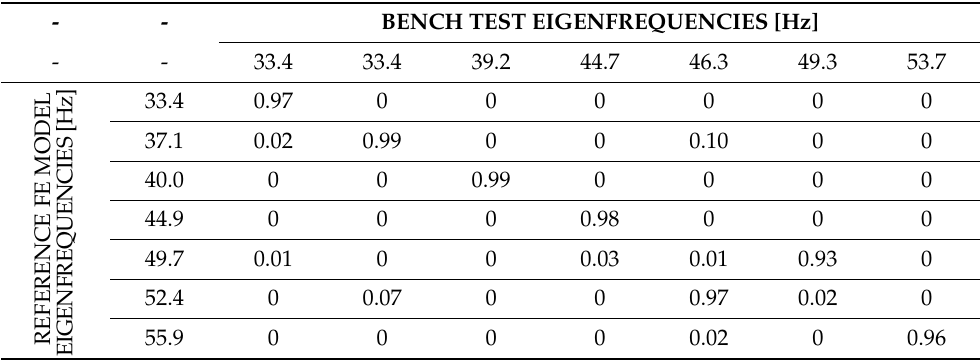
Table 5. MAC results of the adjusted FE model of the vehicle body structure.